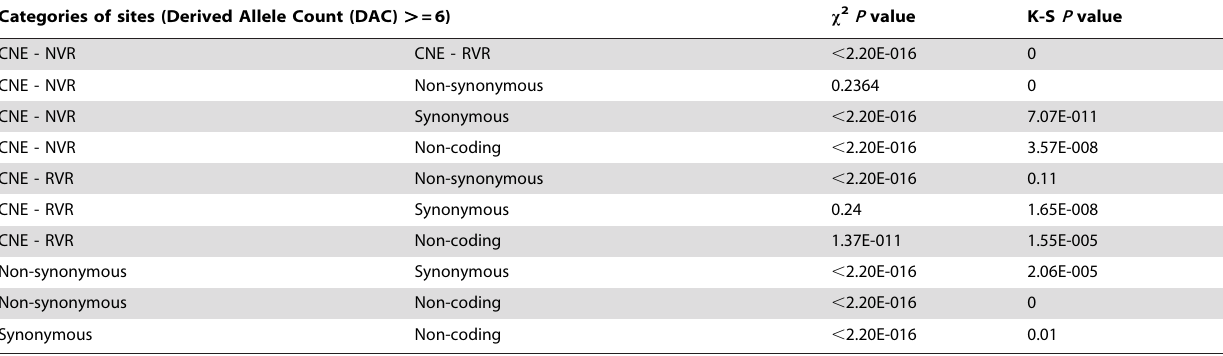
Categories of sites (Derived Allele Count (DAC) .